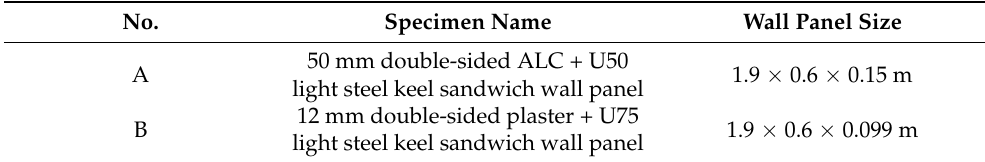
Table 1. Name and dimensions of the specimens used in the fire resistance test of the wall panel. No.